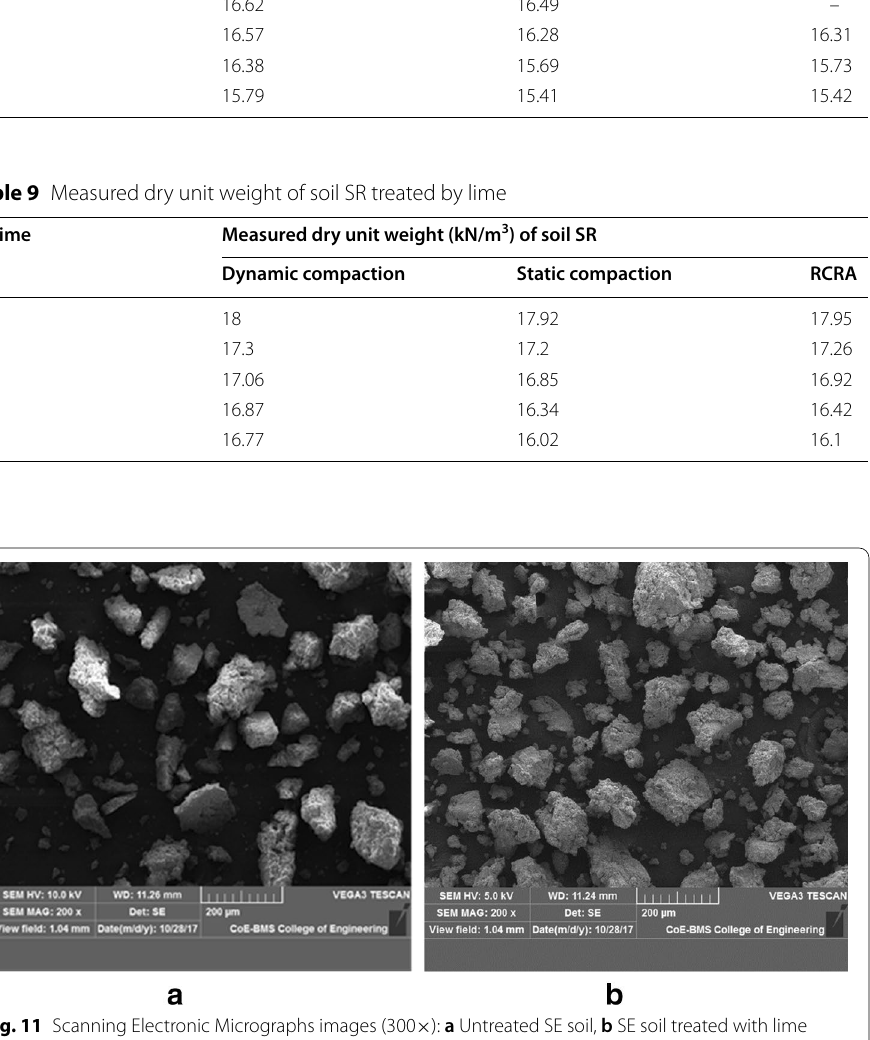
): a Untreated SE soil, b SE soil treated with ×